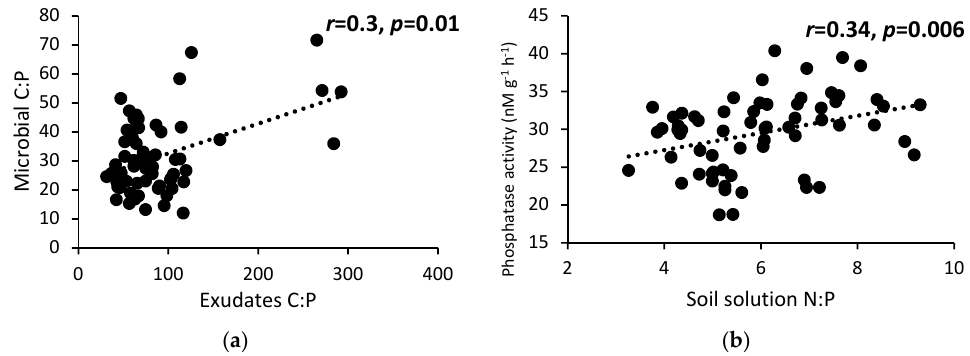
Figure 3. Correlation between C:P ratio of exudates and microbial biomass ( a ) and between soil solution N:P ratio and phosphatase potential activity ( b ). r =-0.31, p =0.01